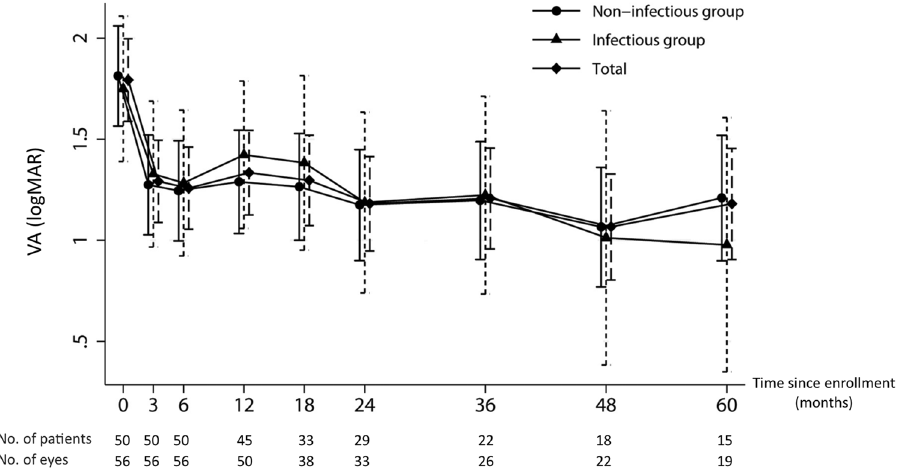
Figure 1. Estimated mean visual acuity (VA) over 5 years in all eyes and in eyes categorized into the non- infectious and infectious uveitis groups. Vertical lines represent 95% confidence intervals. logMAR logarithm of the minimum angle of resolution.